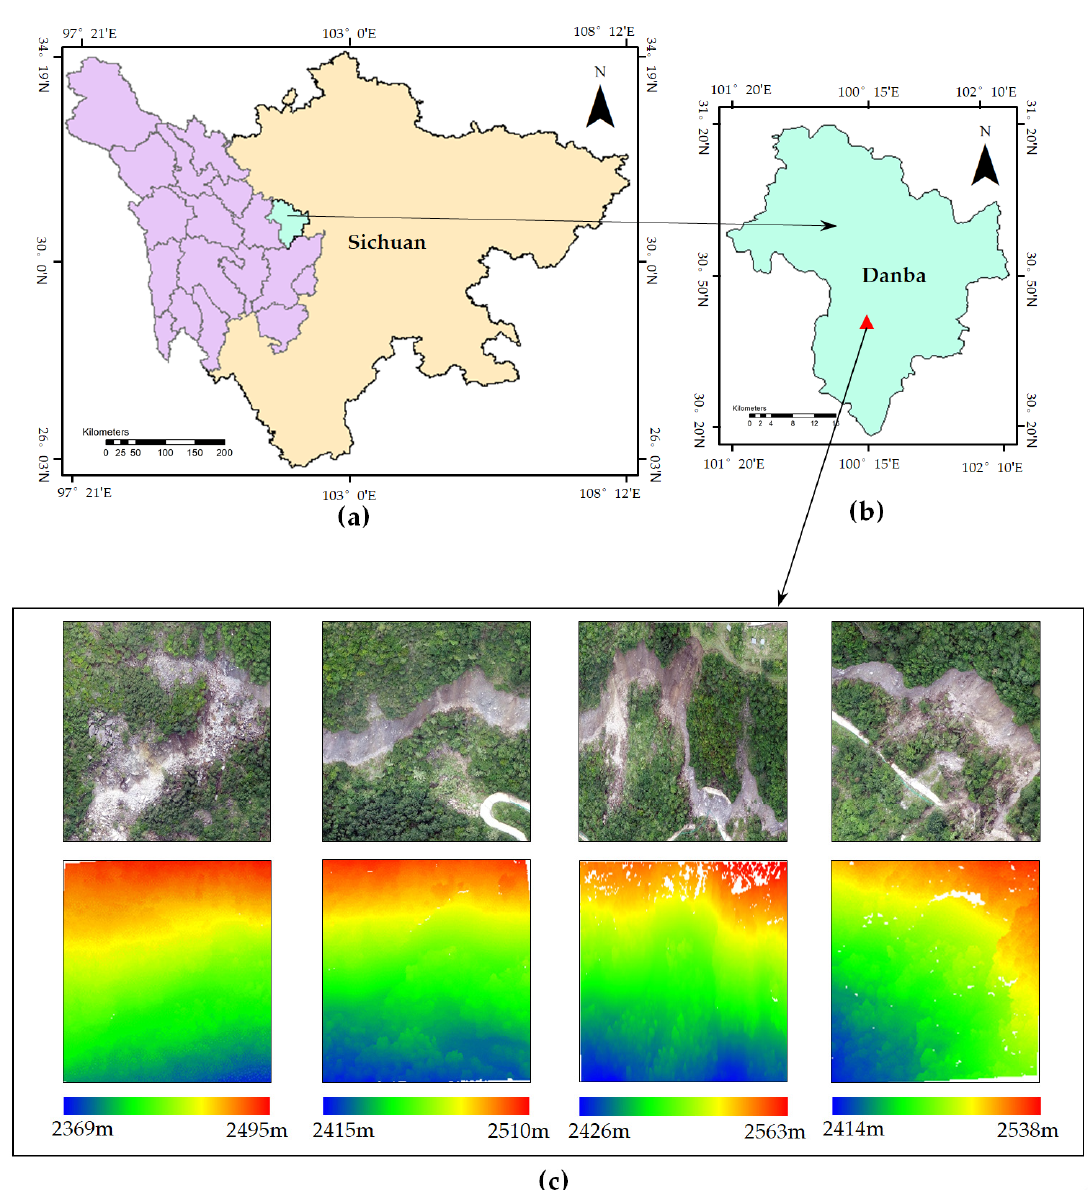
Figure 6. Study area located in Danba County, Sichuan Province, China. ( a , b ) show the location of the study area, and the DOMs and DSMs of the study area are illustrated in ( c ).